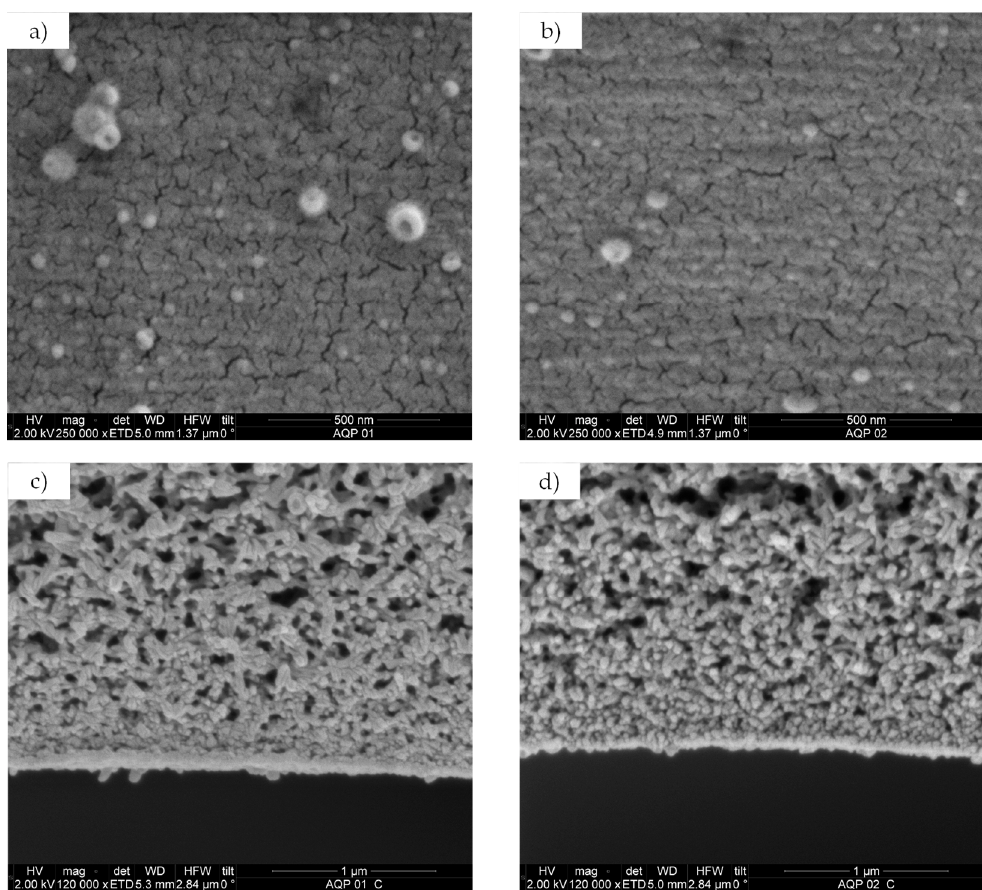
Figure 4. Scanning electron microscopy (SEM) image of the inner surface of ( a ) HF–O, ( b ) HF–C membrane and cross-section of ( c ) HF–O, and ( d ) HF–C membrane. Membranes 2018 , 8 , x FOR PEER REVIEW